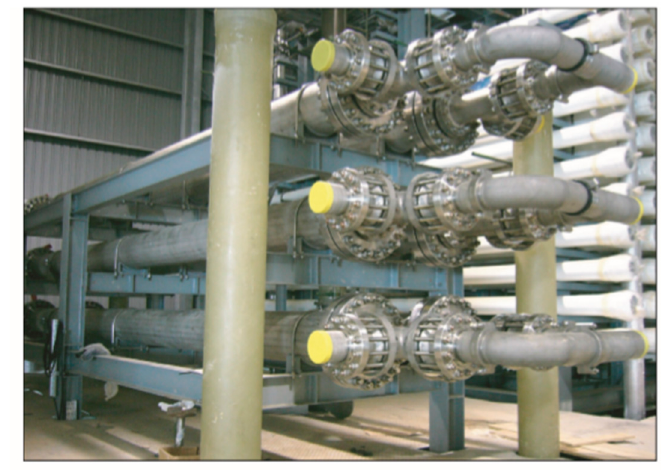
Figure 6. Rack design of a triple DWEER TM [ Error! Reference source not found. ].